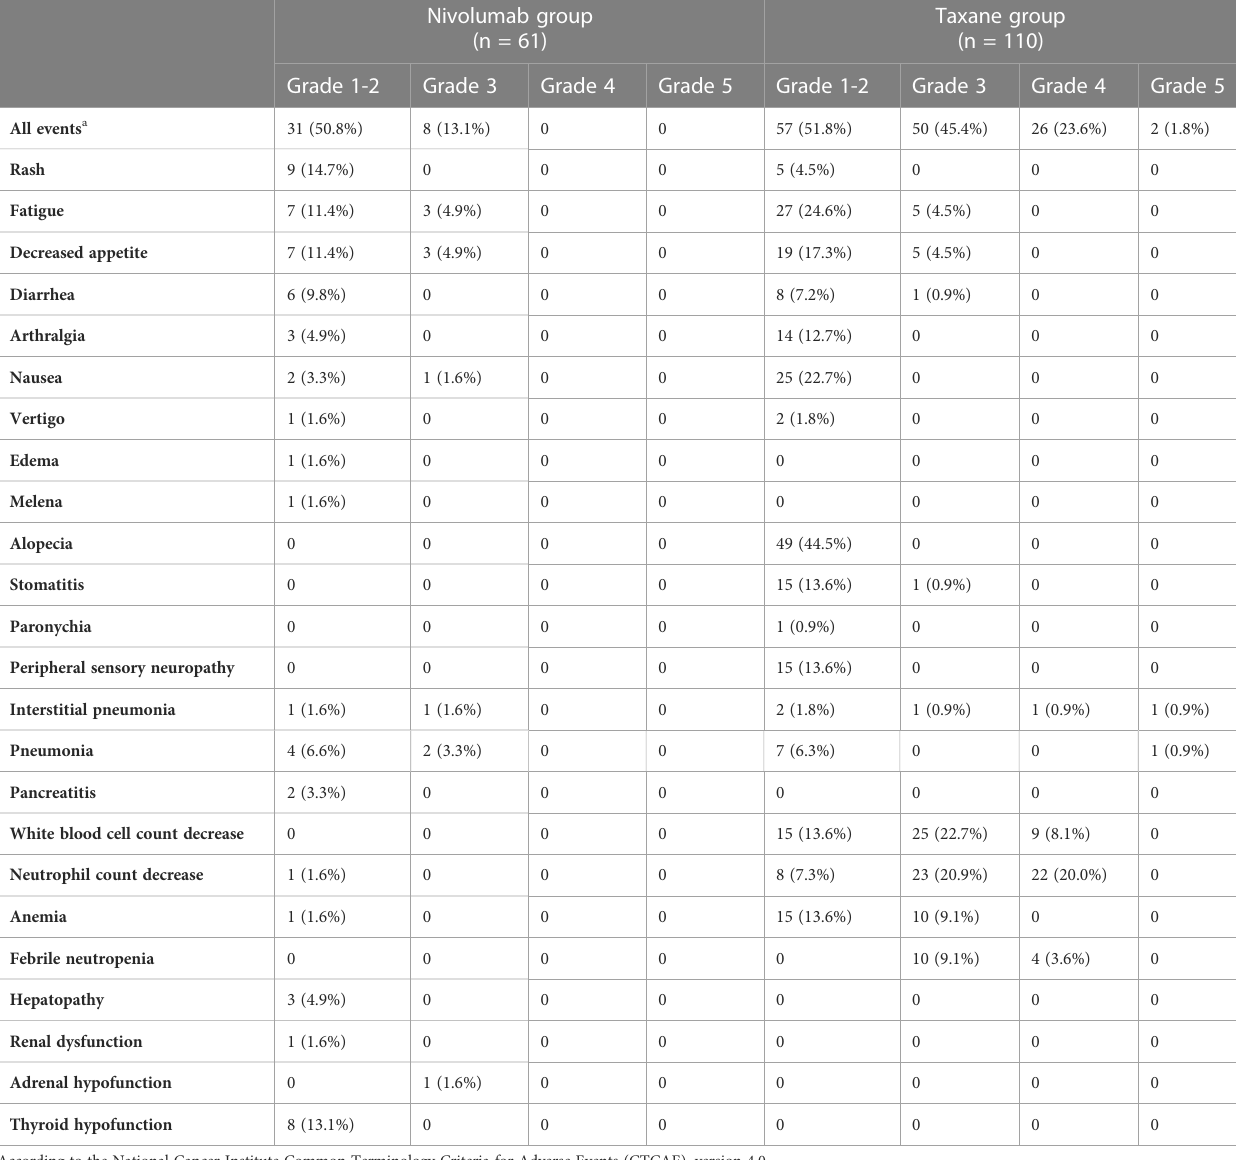
TABLE 3 Summary of treatment-related adverse